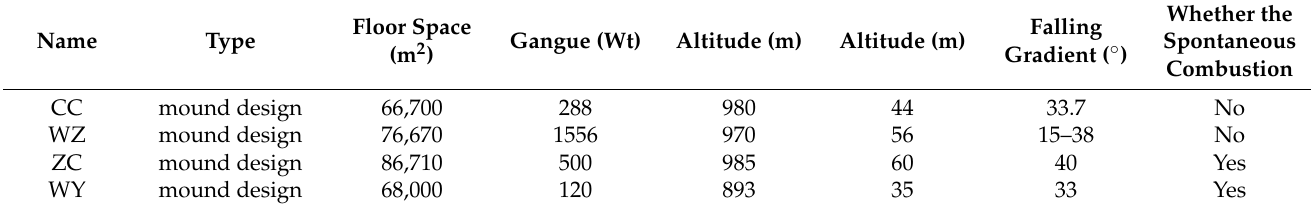
Table 1. Four research gangue pile questionnaires.